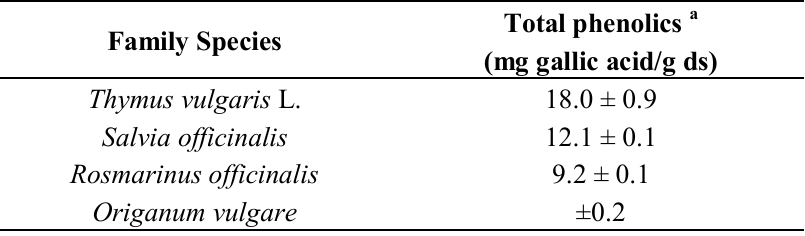
Table 2. Total phenolics in essential